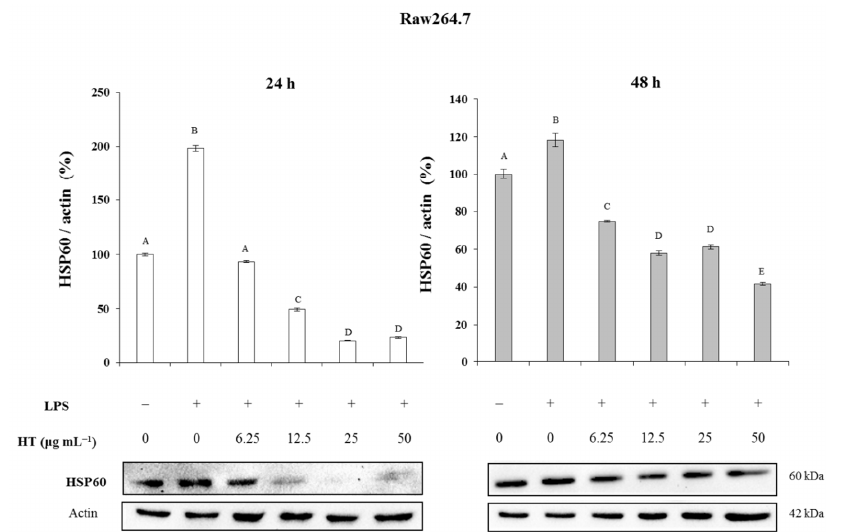
Figure 9. Effect of hydroxytyrosol (HT) on the expression levels of HSP60, a marker protein of the inflammation process in Raw264.7 cells previously subjected to inflammation caused by LPS (0.1 µ g · mL − 1 ). Quantification of protein levels by densitometric analysis is shown in bar graphs. Results are means ± SEM ( n = 9) and are expressed as percentage of expression compared to actin levels in Western-blot analysis. Different capital letters indicate the existence of significant differences (from p < 0.01 to p < 0.001) in the different experimental conditions. HSP60, Heat shock proteins (Chaperon) of 60 kDa; LPS, Lipopolysaccharide.